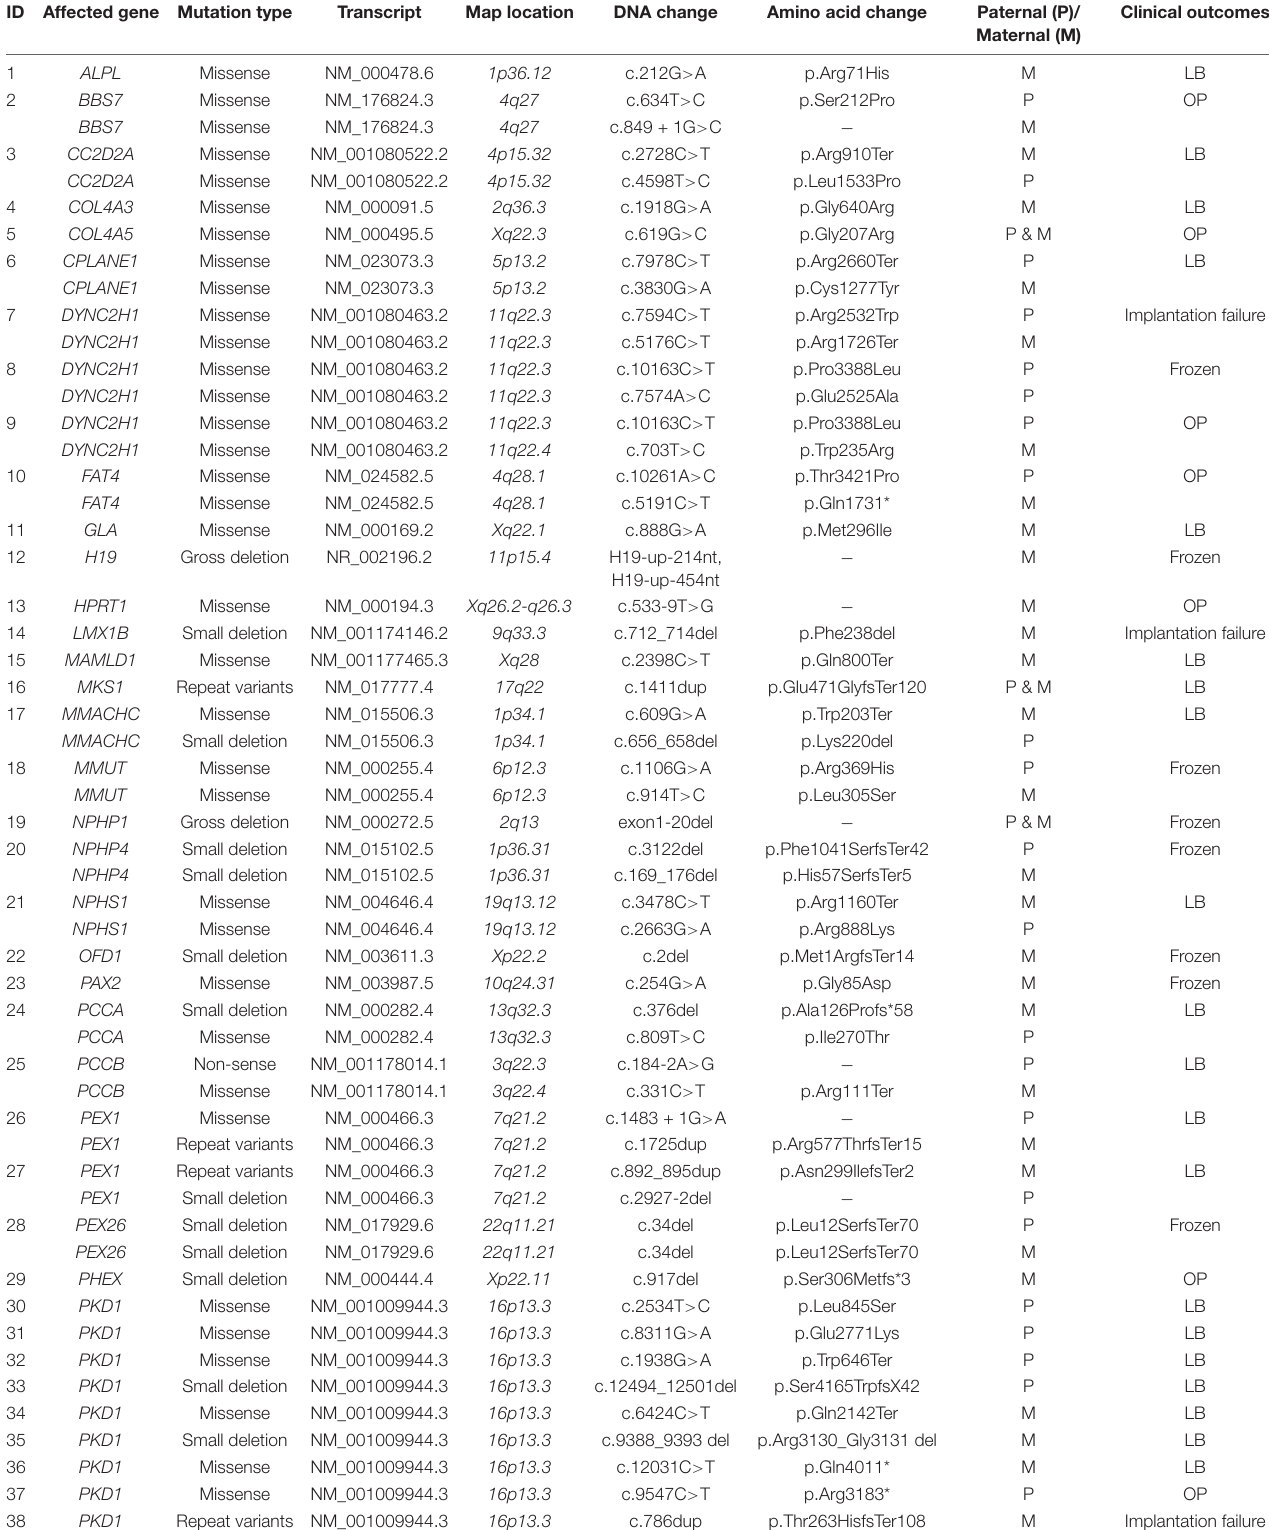
TABLE 2 | Genes and variants list in the preimplantation genetic testing for monogenic disease (PGT-M) cohort of genetic kidney diseases/syndromes with renal phenotypes cohort. ID Affected gene Mutation